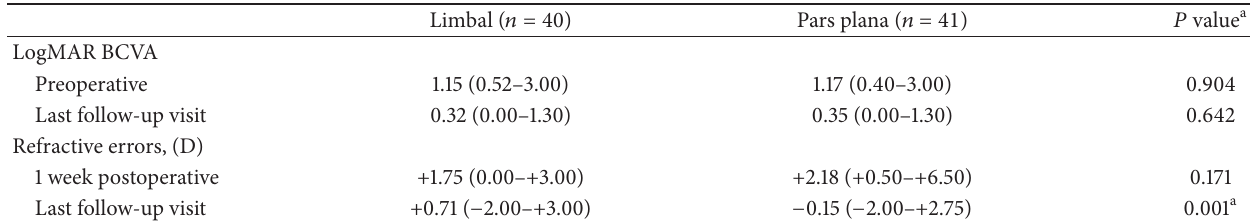
Table 2: Visual outcomes.